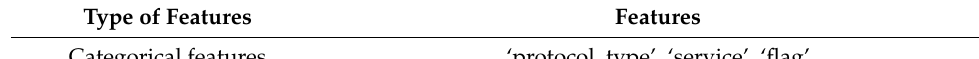
Table 1. The type of features.